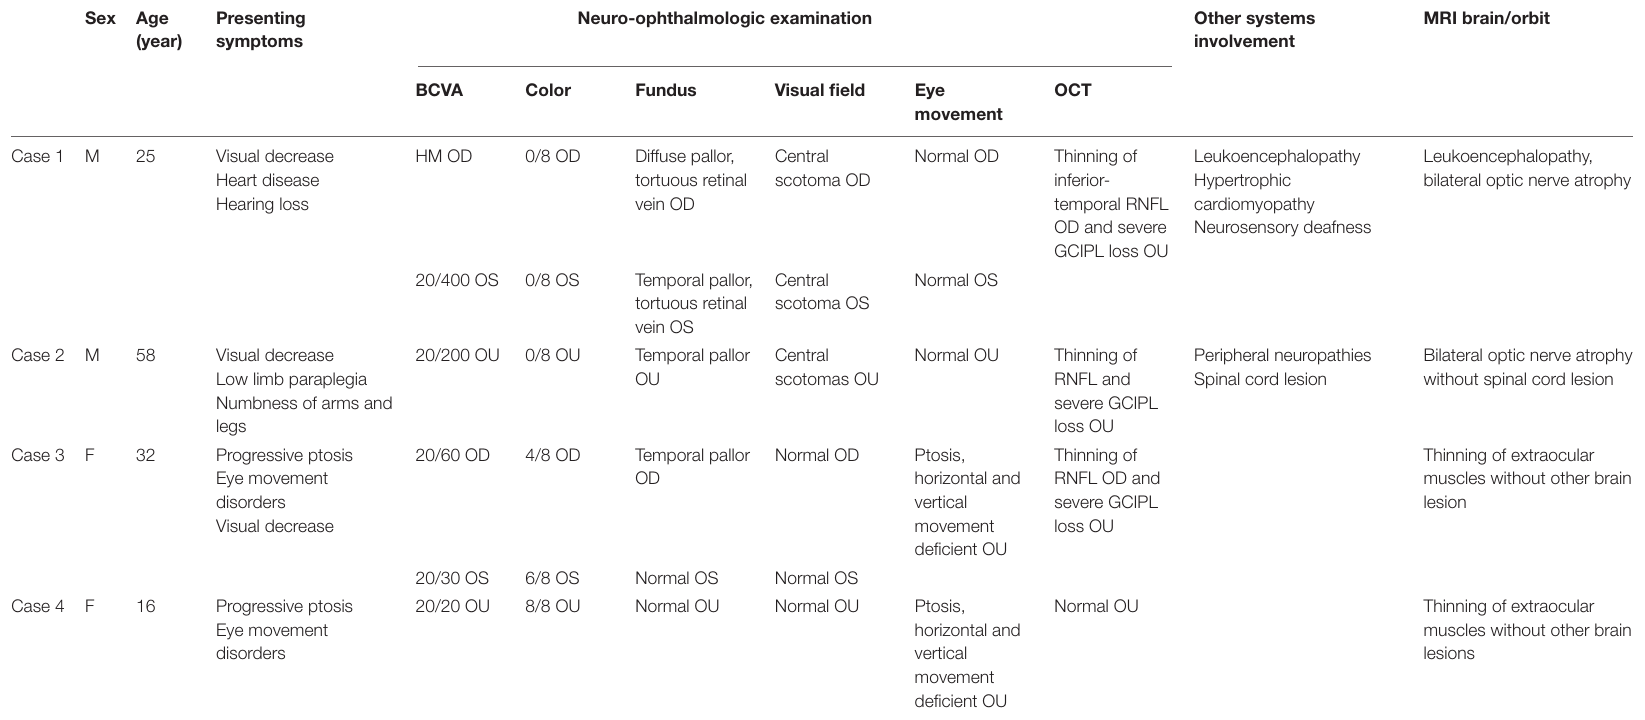
TABLE 1 | Clinical manifestations of the four